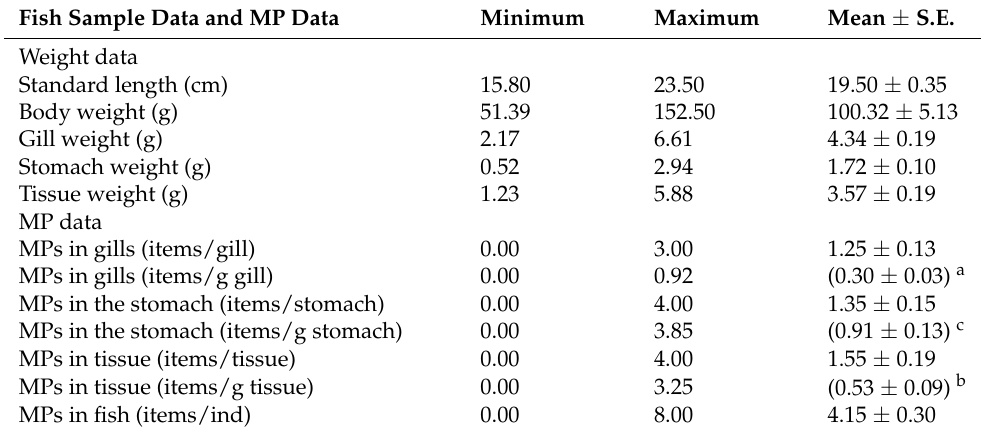
Table 1. Data of catfish size measurement and the quantity of microplastics found in catfish